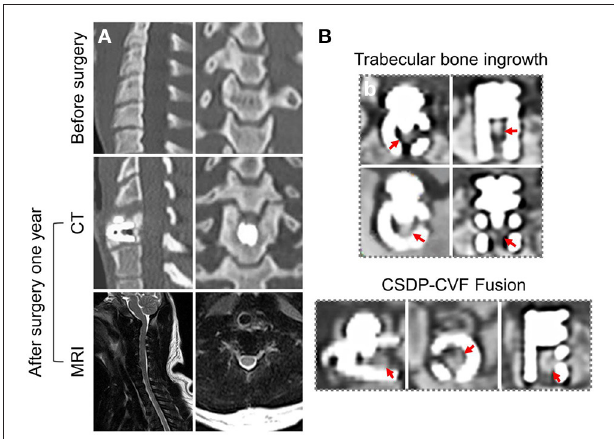
FIGURE 12 | Radiological observation of cervical subtotal discectomy prosthesis (CSDP) in non-human primates. (A) CT and MRI 1 month before and 1 year after CSDP implantation in non-human primates. (B) The trabecular bone grows into the interior of the cervical vertebra fixation (CVF) structure through the